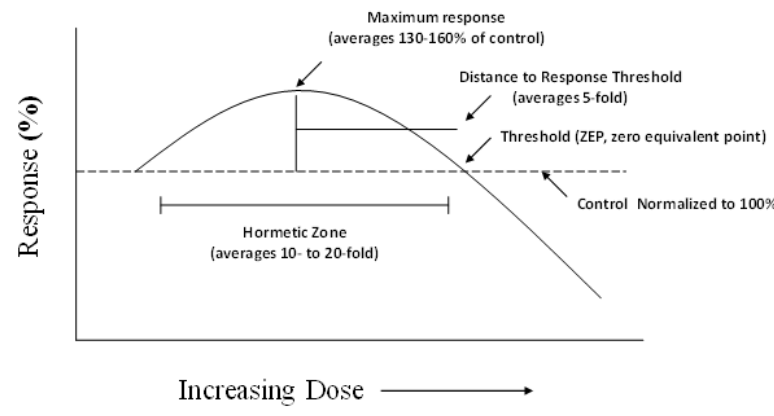
Figure 1. Dose–response curve representing the quantitative features of hormesis (Source: [7]). Table 1. Hormetic effect with ginseng mixtures/specific constituents and biological models.